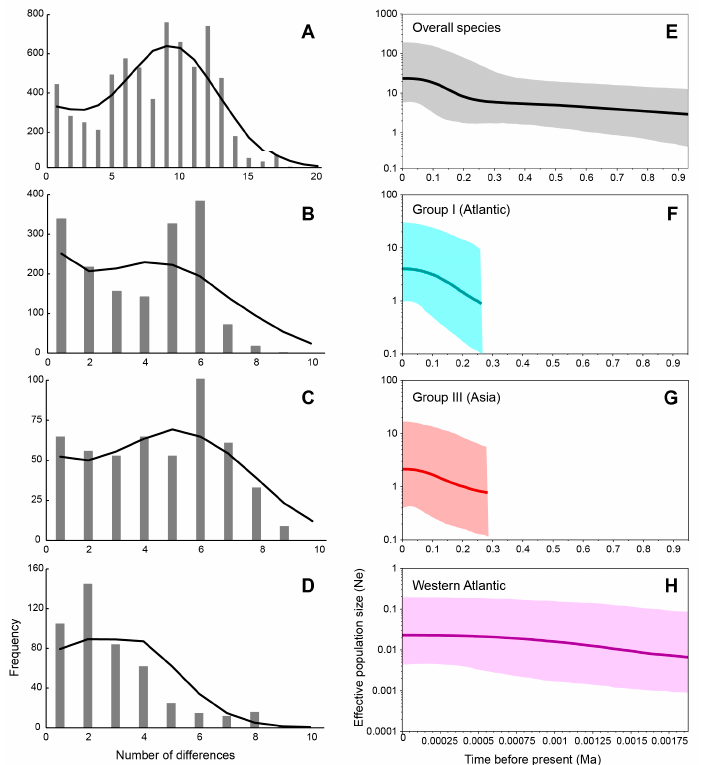
Figure 3. Mismatch distribution analysis (MDA) and Bayesian skyline plot (BSP) of Gelidium crinale using a mitochondrial COI-5P dataset. ( A ) MDA of overall species; ( B ) MDA of group I; ( C ) MDA of group III; ( D ) MDA of the Western Atlantic realm; ( E ) BSP of overall species; ( F ) BSP of group I; ( G ) BSP of group III; ( H ) BSP of the Western Atlantic realm. For mismatch distributions, the grey bar charts represent the observed distributions, whereas the black lines represent simulated data under a sudden expansion model. For BSPs, the x -axis represents the time since the present in years and the y -axis represents the estimated effective population size ( N e ). Light blue color indicates BSP for Group I, red for Group III, and pink for the Western Atlantic. The solid center line is the median estimate, and the upper and lower lines indicate the 95% highest posterior density (HPD) intervals for N e